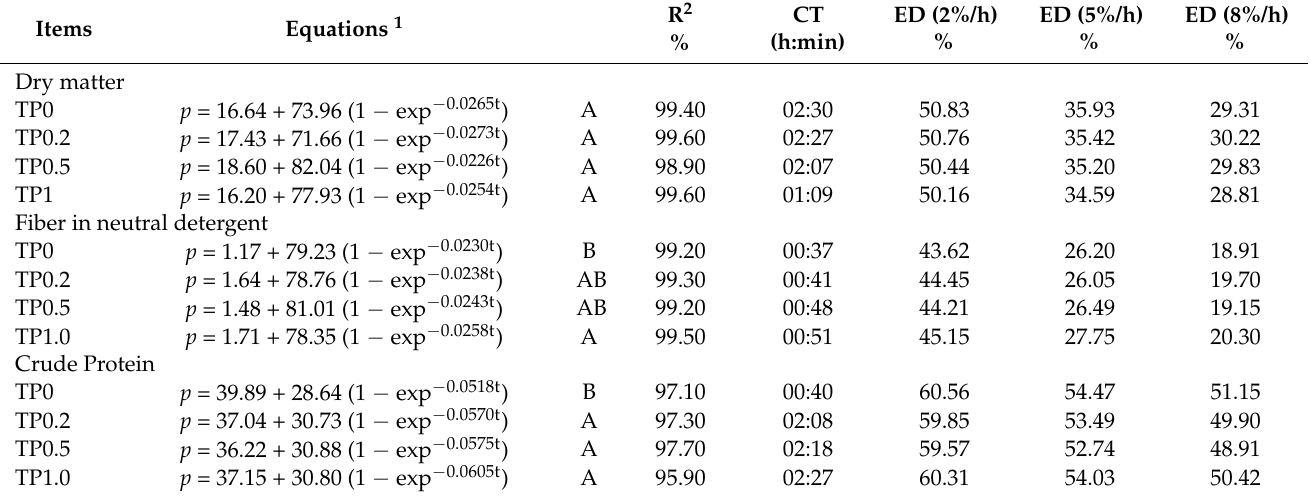
Table 7. Equations for ruminal degradation, colonization time (CT), effective degradability (ED) of dry matter (DM), fiber in neutral detergent (NDF) and crude protein (CP) of Marandu grass as a function of increasing levels of palm kernel cake for buffaloes in the eastern